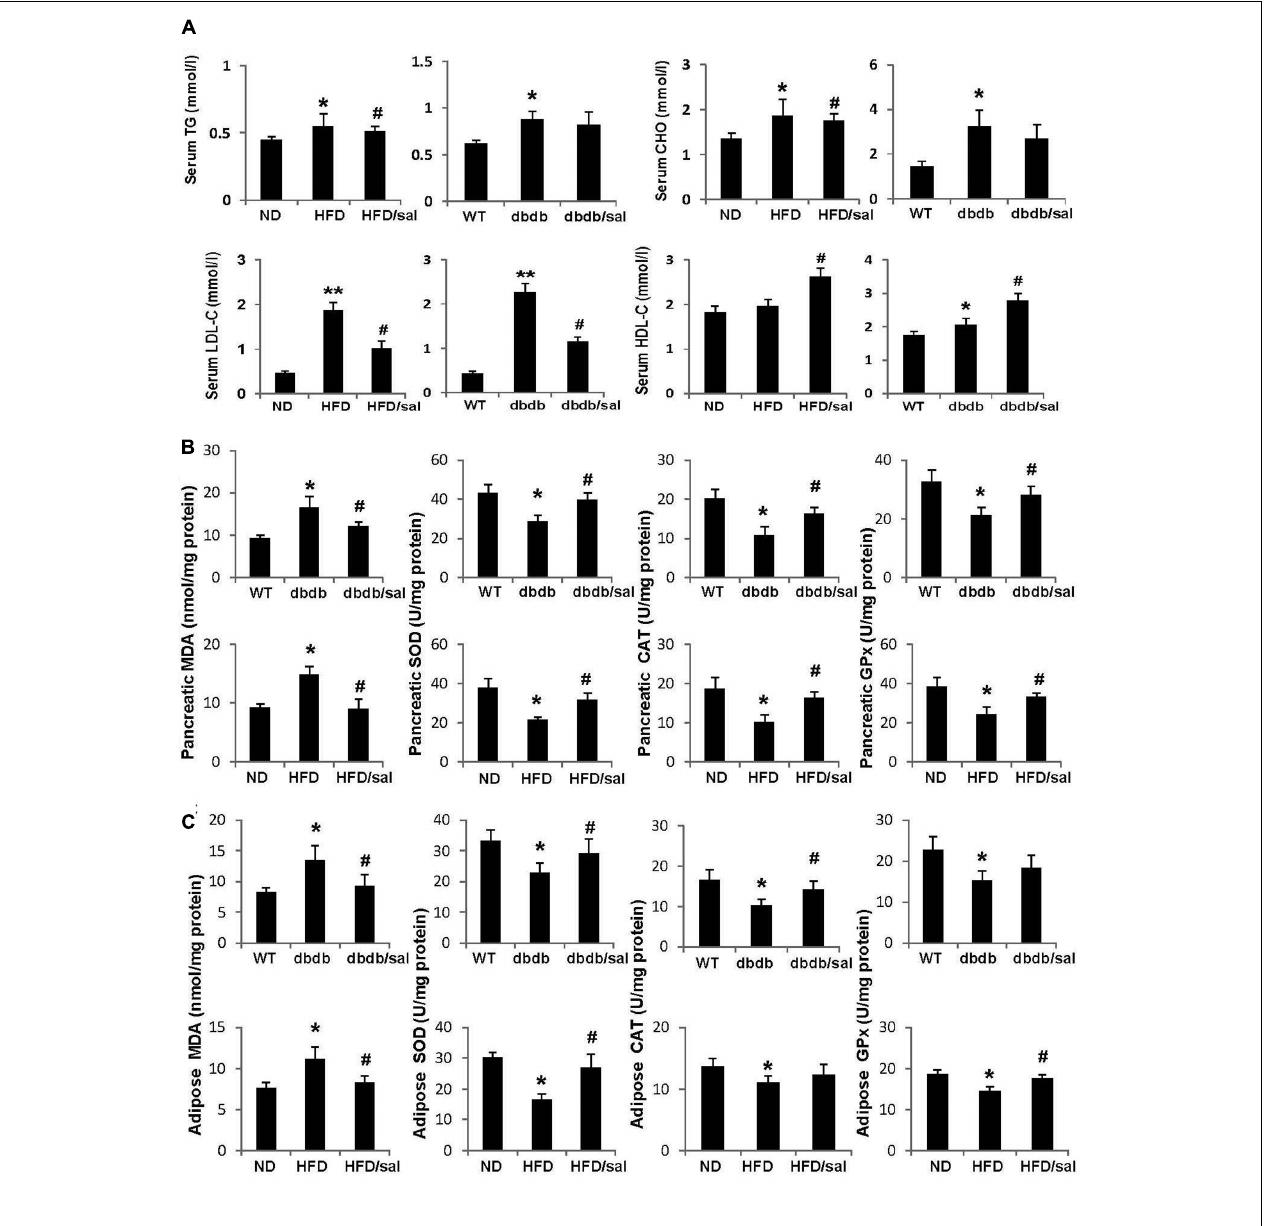
FIGURE 2 | Salidroside presented anti-oxidant activities in db/db and HFD mice. (A) The serum triglyceride (TG), total cholesterol (CHO), low-density lipoprotein cholesterol (LDL-C), and high-density lipoprotein cholesterol (HDL-C) levels were examined in db/db and HFD mice. (B) Enzyme activities of SOD, CAT, GPx, and MDA content were measured in pancreas of mice. (C) Enzyme activities of SOD, CAT, GPx, and MDA content were measured in adipose tissue of mice. Data are shown as mean ± SE, n = 6 ( ∗ p < 0.05, ∗∗ p < 0.01, db/db to WT or HFD to ND, # p < 0.05, dbdb to dbdb/sal or HFD to HFD/sal).